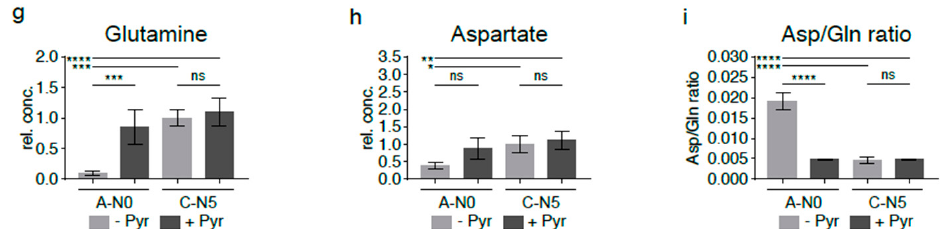
Figure 4. Reversal of altered metabolic flux/reductive stress in asparagine-depleted mouse sarcoma cells by supplementation with pyruvate. ( a ) Relative lack of electron acceptors as evidenced by reduced NAD + /NADH rations was consistent with reductive stress in asparagine-starved A-N0 cells compared to control cells cultured in near-physiological asparagine conditions (C-N5, W-N5). Pyruvate and asparagine supplementation rescued the reduced NAD + /NADH ratios in asparagine- depleted sarcoma cells. Pyruvate and asparagine supplementation also reversed the ( b ) increased lactate/pyruvate ratios and ( c ) reduced malate/oxaloacetate ratios in A-N0 compared to C-N5/W-N5 cells. ( d ) Asparagine-deprived shASNS cells (A-N0) were grown in medium containing 0 mg/L asparagine, 5 mg/L asparagine and 100 mg/L asparagine and supplemented with exogenous pyruvate at a concentration of 88.06 mg/L (1 mM). ( e ) GC-MS data were evaluated by principal component analysis, which demonstrated reversal of the global metabolomic changes in asparagine- depleted cells (A-N0, marked in red) compared to control cells (marked in shades of blue) after pyruvate supplementation (A-N0-P, marked in pink); shASNS cells grown in medium with excess asparagine are marked in green. ( f ) Further LC analyses again demonstrated that reversal of metabolic changes in asparagine-depleted cells (A-N0) included TCA cycle metabolites, which were restored in asparagine-depleted cells supplemented with pyruvate (A-N0-P) to levels comparable to those in control cells (C-N5). ( g ) Pyruvate supplementation restored glutamine levels in asparagine- depleted cells compared to control cells. ( h ) Pyruvate supplementation raised aspartate levels in asparagine-deprived cells, but these changes did not reach significance. ( i ) Pyruvate supplementation restored aspartate/glutamine rations in asparagine-depleted cells. Please see Table S4 for lists of metabolites detected in cell lysates by GC-MS. Please see Figure S6 for lower oxygen consumption rates in asparagine-starved compared to control cells. Data were evaluated for statistical significance by one-way ANOVA with Tukey’s post-hoc test (ns p ≥ 0.05, * p < 0.05, ** p < 0.01, *** p < 0.001, **** p <